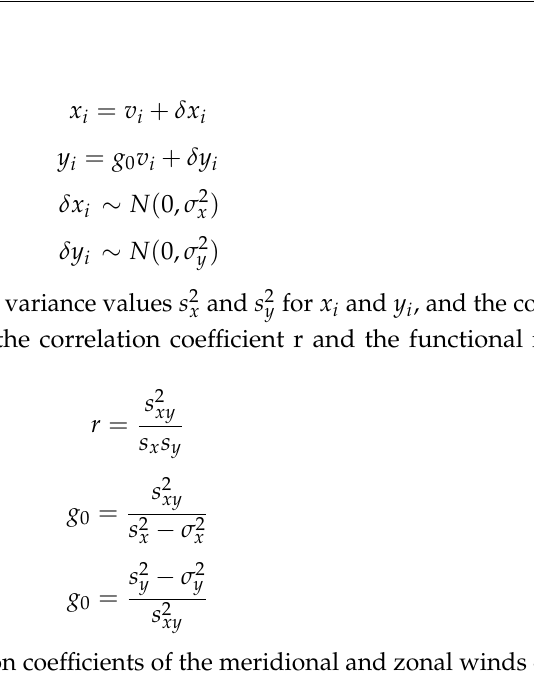
Table 2. The correlation coefficients of the meridional and zonal winds obtained from MIGHTI/ICON and meteor radar at different altitudes. Number of Meridional Wind Height (km) Samples Correlation Coefficient 94